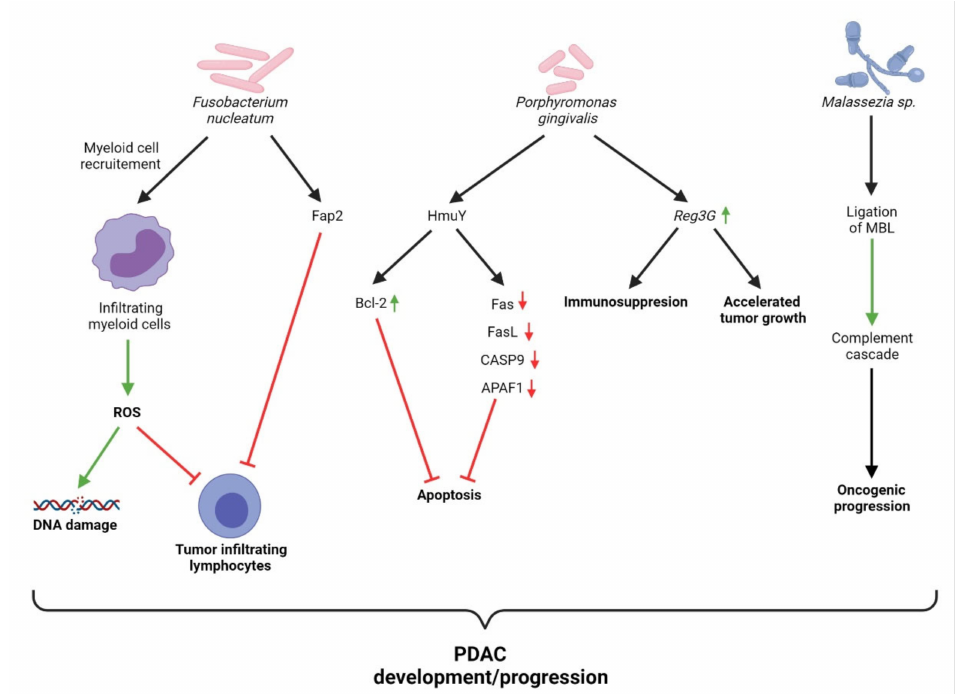
Figure 4. Overview of mechanisms of bacterial-mediated carcinogenesis of